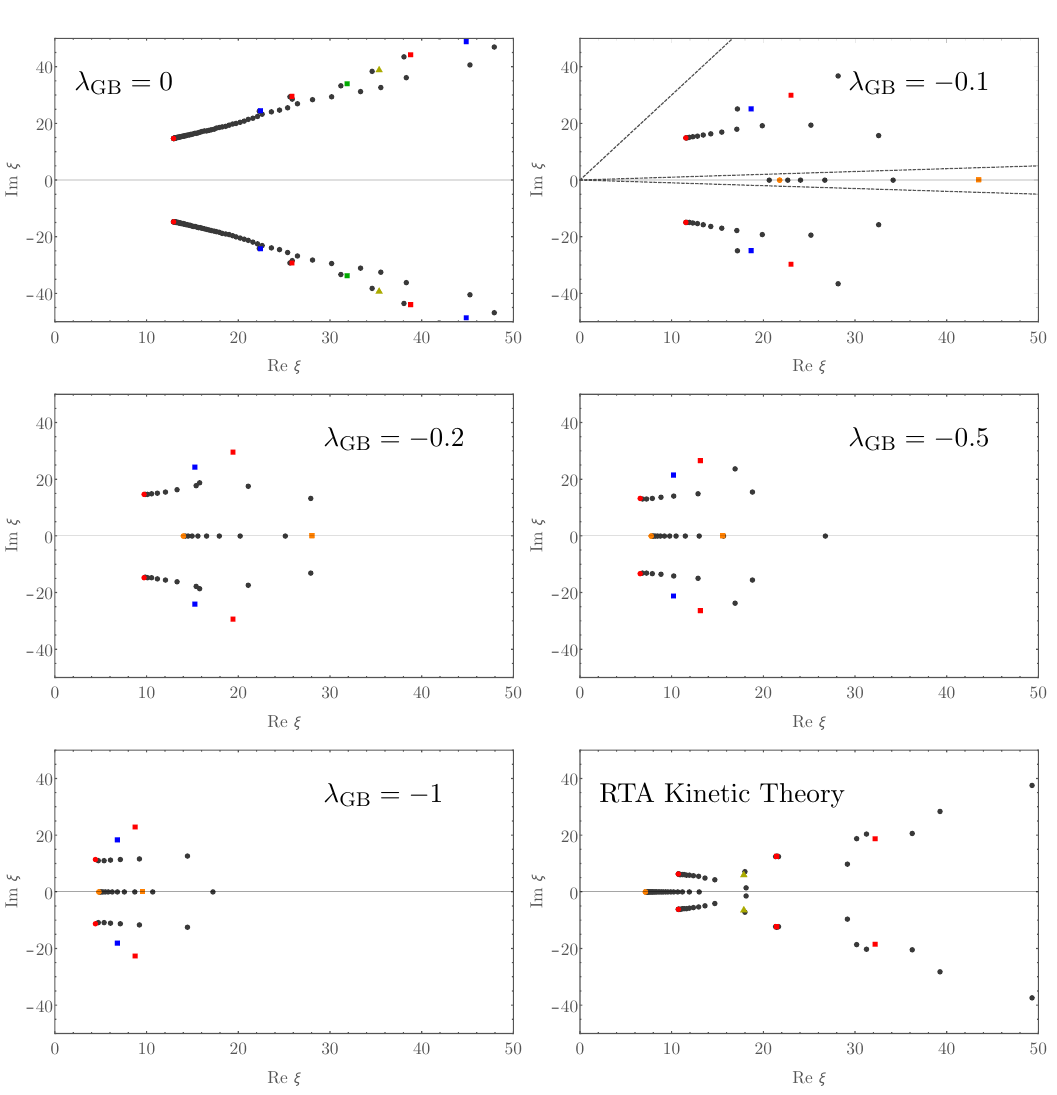
Figure 2 . The lower right panel is the Borel plane of kinetic theory in the RTA approximation using the coe(cid:14)cients computed in [29]. For this plot we have chosen the product of the relaxation time times temperature, (cid:13) (cid:17) (cid:28) R T = (cid:25)= 15, so that shear viscosity of the RTA coincides with the (cid:21) GB = (cid:0) 1 value. The straight dashed lines in the upper left channel shows the contours of integration used in section. (4), C c , C + and C (cid:0) in decreasing slope order. Similar contours are used for all other cases. The solid grey circles indicate poles of the Pad(cid:19)e approximant of R B ( (cid:24) ), the Borel transform associated with the anisotropy function R ( w ) for di(cid:11)erent values of (cid:21) GB . The expected positions of singularities predicted from the quasi-normal mode frequencies closest to the origin, both for complex (red) and purely dissipative modes (orange), are marked by solid circles. All integer multiples of these frequencies are given by squares of the same colour. The subsequent 2 nd and 3 rd QNM frequencies are marked by blue and green squares. The modes that correspond to the sum of the 1 st and 2 nd QNM frequencies (in the N = 4 case) or the sum of the (cid:12)rst two leading modes (in the RTA case) are given by a yellow